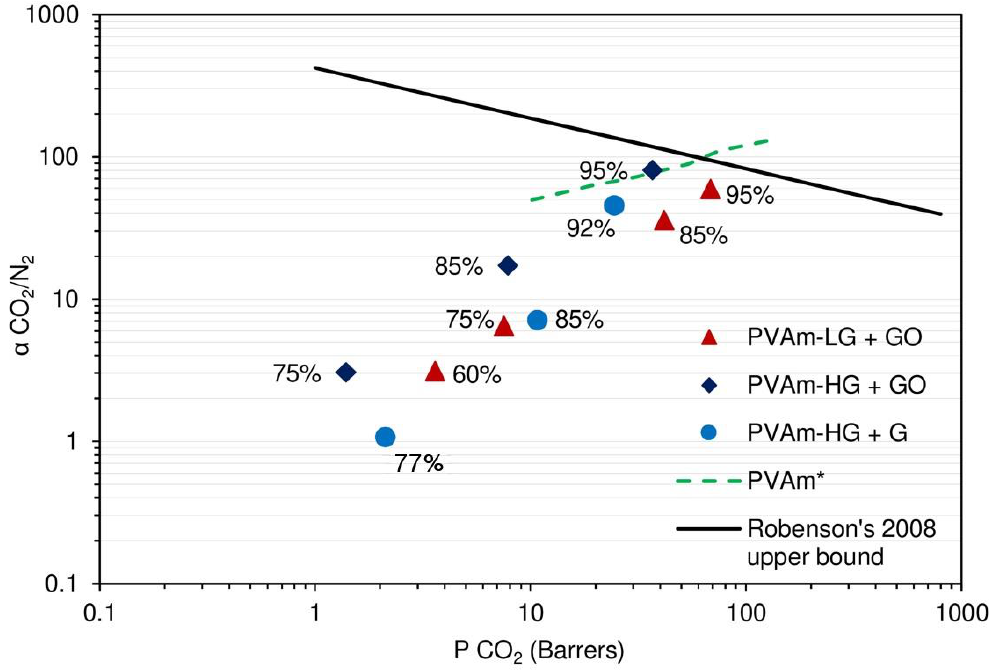
Figure 11. CO 2 /N 2 selectivity of graphene loaded films on a Robeson plot. PVAm* data refer to pure PVAm permeability as obtained in Ref. [43] .